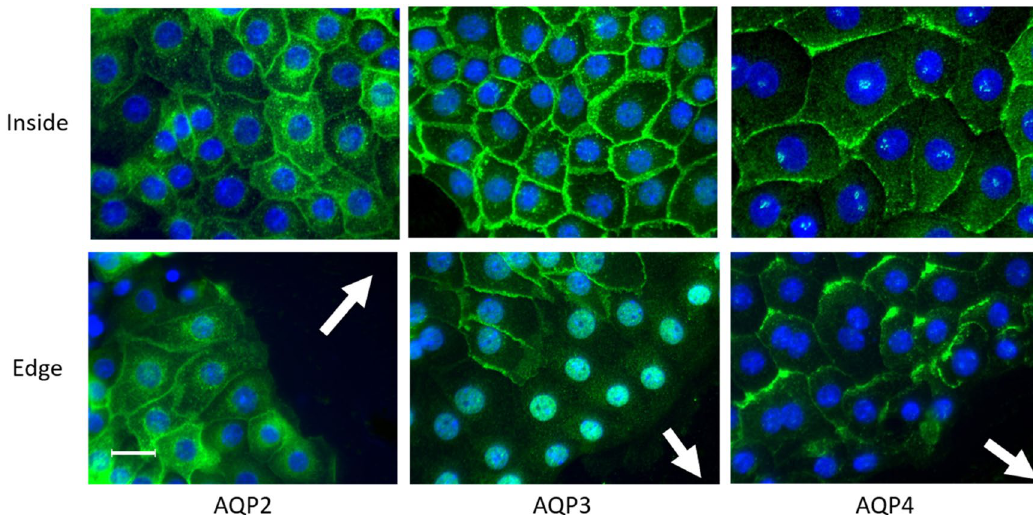
Figure 6. Migration influences the localization of AQPs. Wound healing assays were performed with IMCD- cells cultivated at 600 mosmol/kg. A scratch was induced and after 4 h the cells were stained for AQP2–4 using specific antibodies. For the AQP2 staining the cells were incubated with dbcAMP to induce membrane localization. Alexa-488 labeled secondary antibodies were used for visualization. The nuclei were stained with DAPI. The upper row show cells away from the wound. The lower rows show cells at the leading edge. Scale bar = 20 µm, representative image chosen from 6 to 9 independent